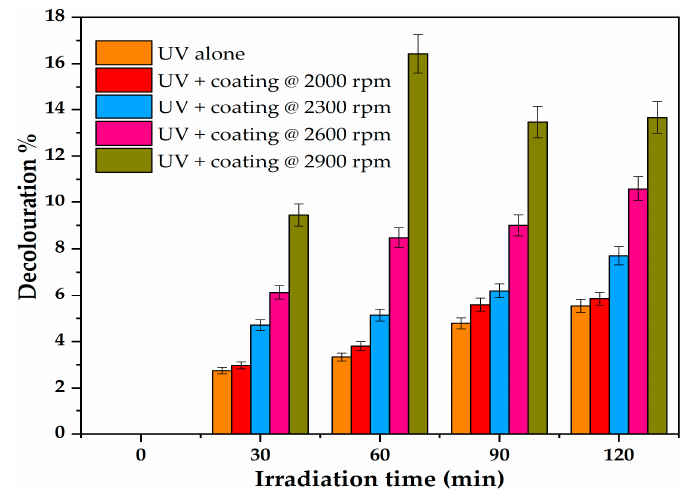
Figure 9. Photocatalytic activity of glass coated with C-N-TiO 2 nano composites at spin coating speed that varied from 2300, 2600, to 2900 rpm at the following experimental conditions: [O.II] concentration 5 mg/L, volume 500 mL, of pH 2.5, and sampled at 30 min intervals over an irradiation time of 120 min. Each photo catalysis experiment was duplicated ( n =